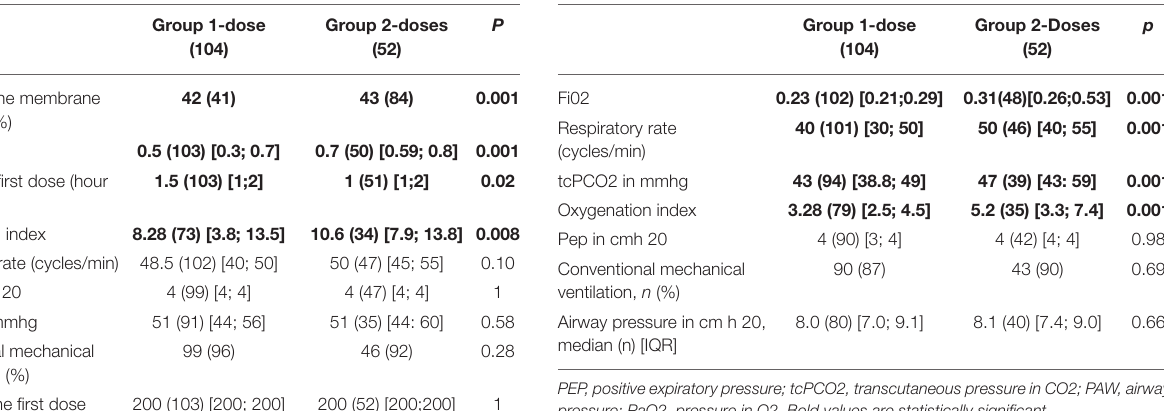
TABLE 2 | Respiratory criteria before surfactant administration. TABLE 3 | Respiratory criteria after surfactant